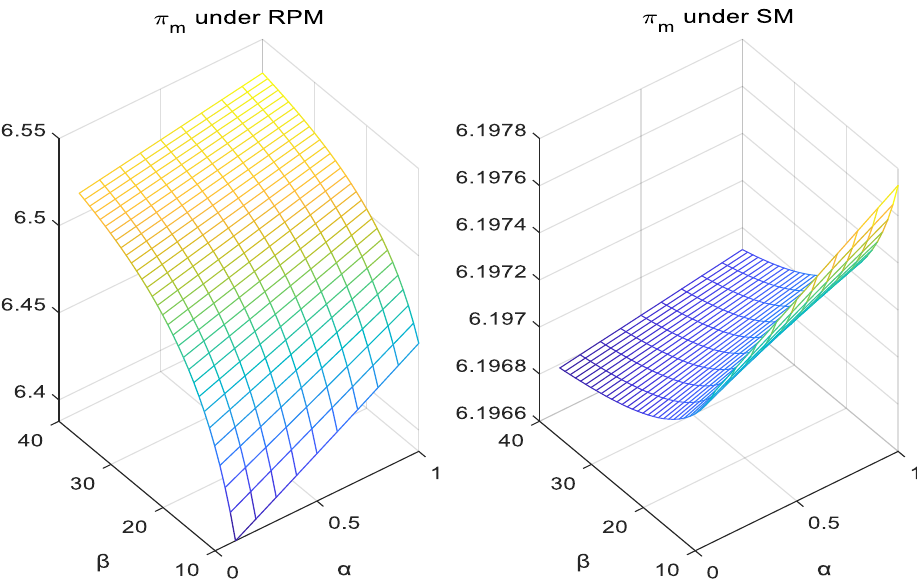
Figure 7. Manufacturer’s profit vs. fixed cost coefficient and environmental benefit coefficient under RPM ( left ) and SM ( right ).